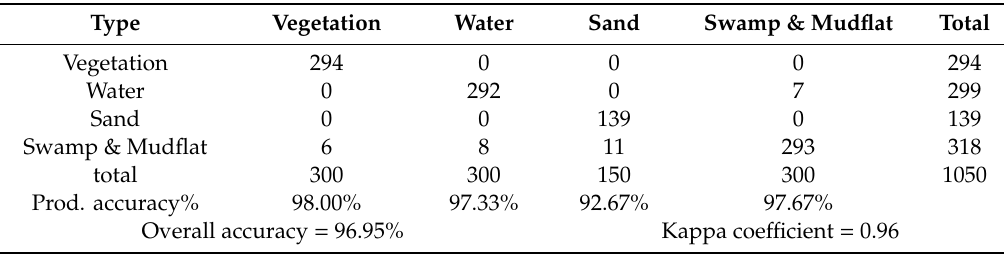
Table 2. Classification accuracy evaluation in 2017.